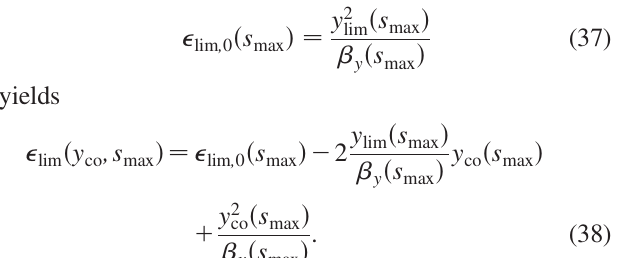
¼ 29 V , f ¼ for U ;i a S